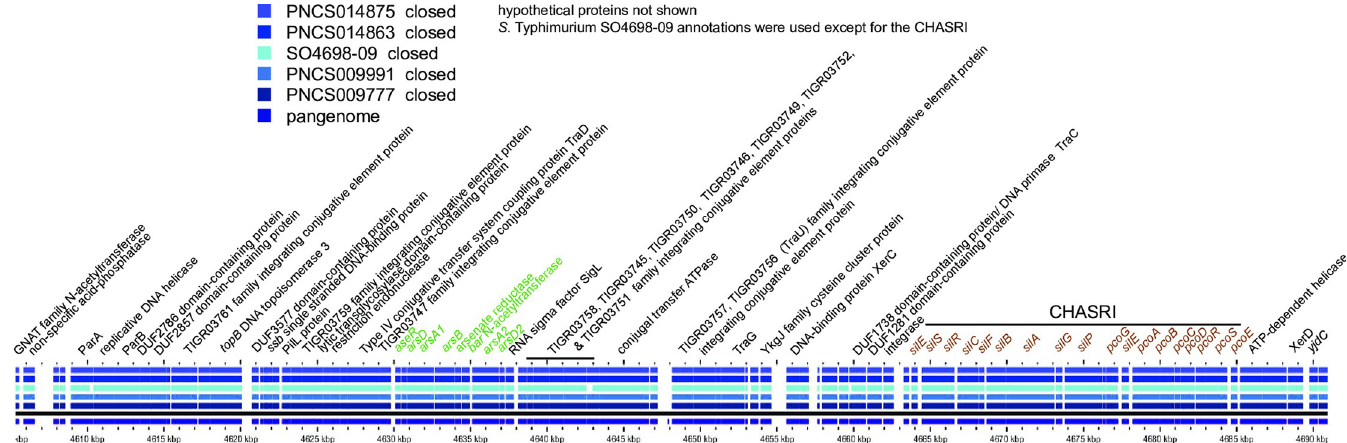
Fig 11. Structure of SGI-4 in four isolates for which closed genome sequences were obtained. The comparison was done using GView Server with the “Pangenome analysis” settings and the figure was annotated in Adobe Illustrator CS6.